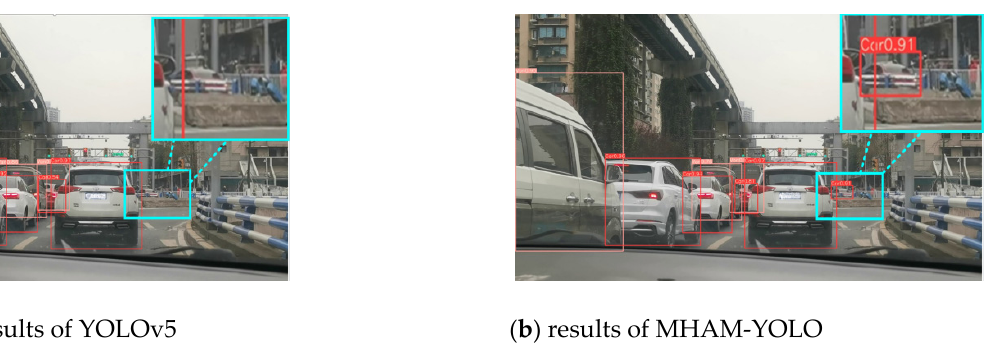
( b ) results of MHAM-YOLO Figure 11. Comparison of the detection effect of dense continuous occlusion of vehicles. By further comparing Figure 11a with Figure 11b, we found that even in the face of a more complex scene of dense and continuous occlusion of vehicles, the method in this paper can also achieve a very ideal detection effect. It can be seen that while the baseline algorithm fails to detect two vehicles blocked by surrounding vehicles, and there are also false detections, MHAM-YOLO relies on its good ability to detect occluded vehicles to effectively detect vehicles that have been occluded with most of the key features. Finally, this paper compares the ability of the two methods to deal with background occlusion, as shown in Figure 12. From the comparison between Figure 12a and Figure 12b, it can be seen that the base-